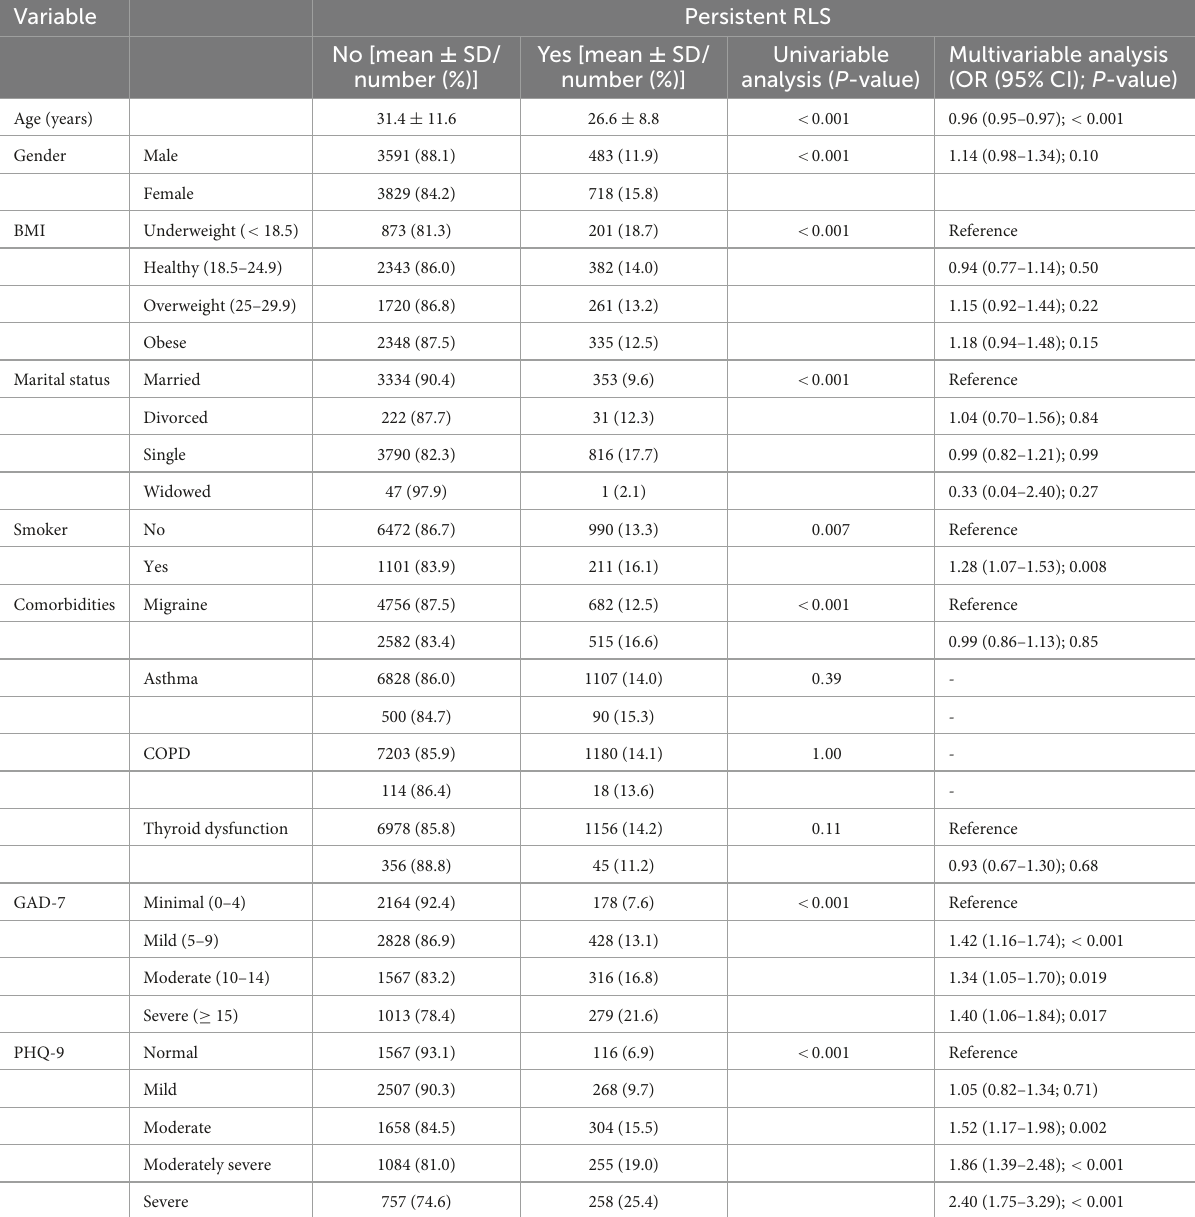
TABLE 2 Univariate and multivariate analysis of risk factors for persistent restless legs syndrome (RLS).